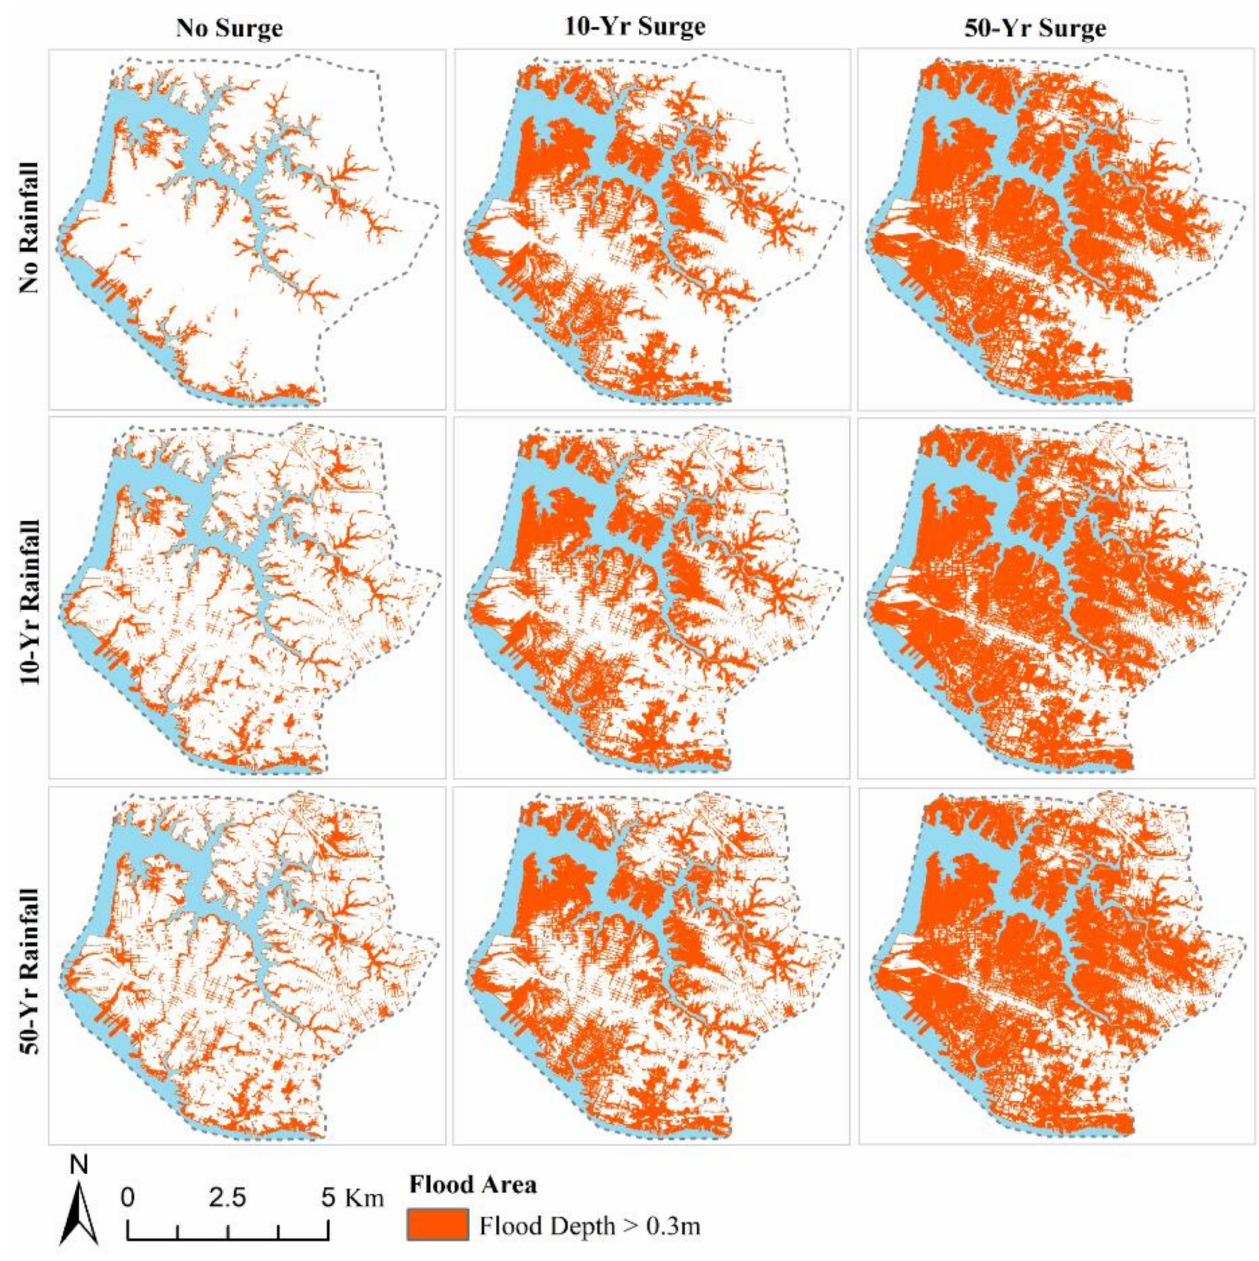
Figure 12. Flood maps for different combined storm scenarios under 2070 climate and sea level